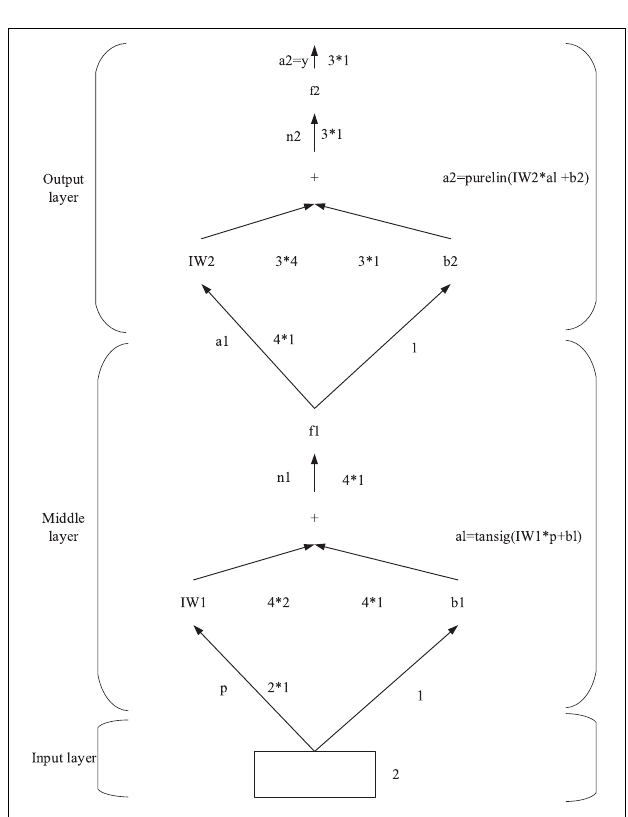
FIGURE 5 | Double-layer